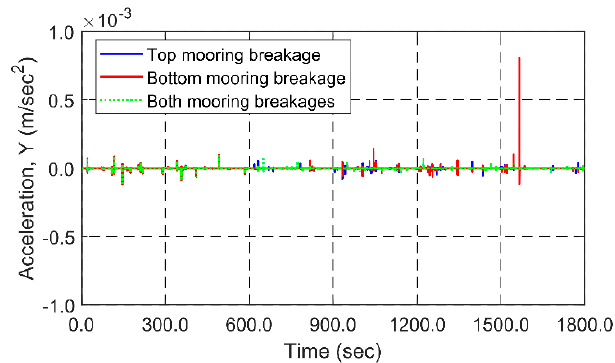
Figure 15 . Time histories of the X ( top ) and Y ( bottom ) directional accelerations of the net assembly in the middle location (Y = 0 m) as mooring lines in the middle location (Y = 0 m) are broken after 600 s ( H s = 2.0 m, T p = 7.0 s, current velocity = 0.6 m/s).